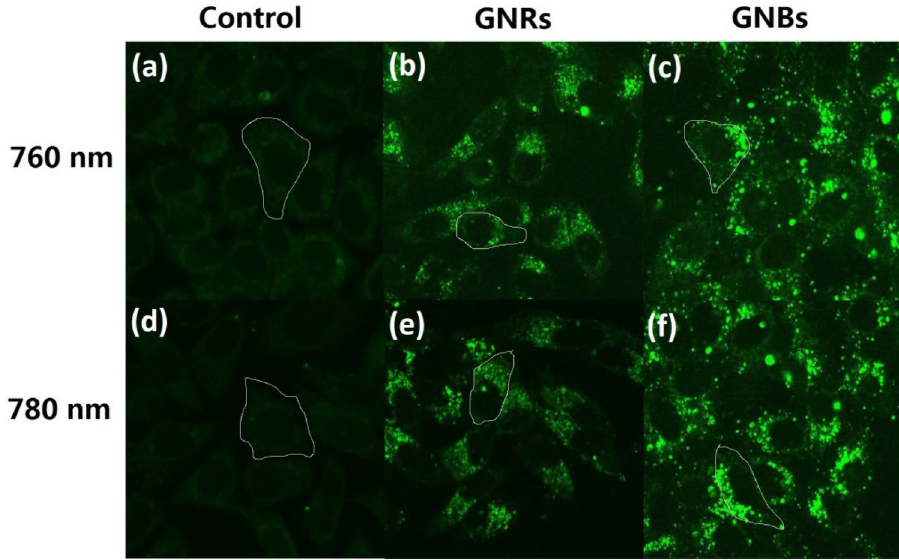
Figure 3. The fluorescence images HepG2 cells under the action of 760 nm fs laser, the selected cell is indicated by white line: ( a ) control group; ( b ) cells incubated with GNRs (AR-3.50) for 24 h; ( c ) cells incubated with GNBs (AR-2.92) for 24 h. The fluorescence images HepG2 cells under the action of 780 nm fs laser: ( d ) control group; ( e ) cells incubated with GNRs (AR-3.71) for 24 h; ( f ) cells incubated with GNBs (AR-3.03) for 24 h.